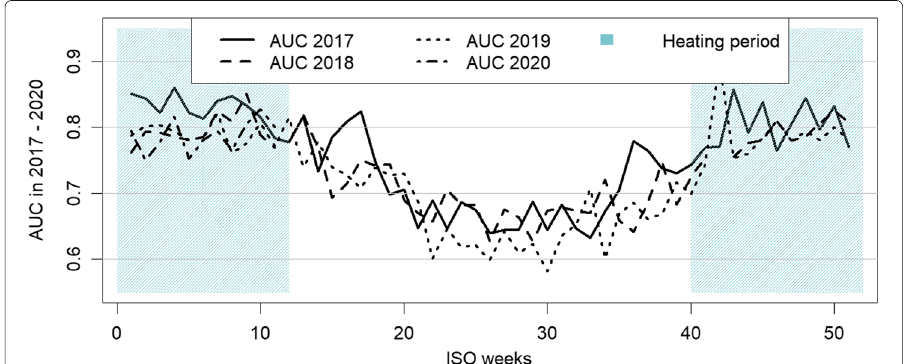
Fig. 3 Detection of heat pumps over